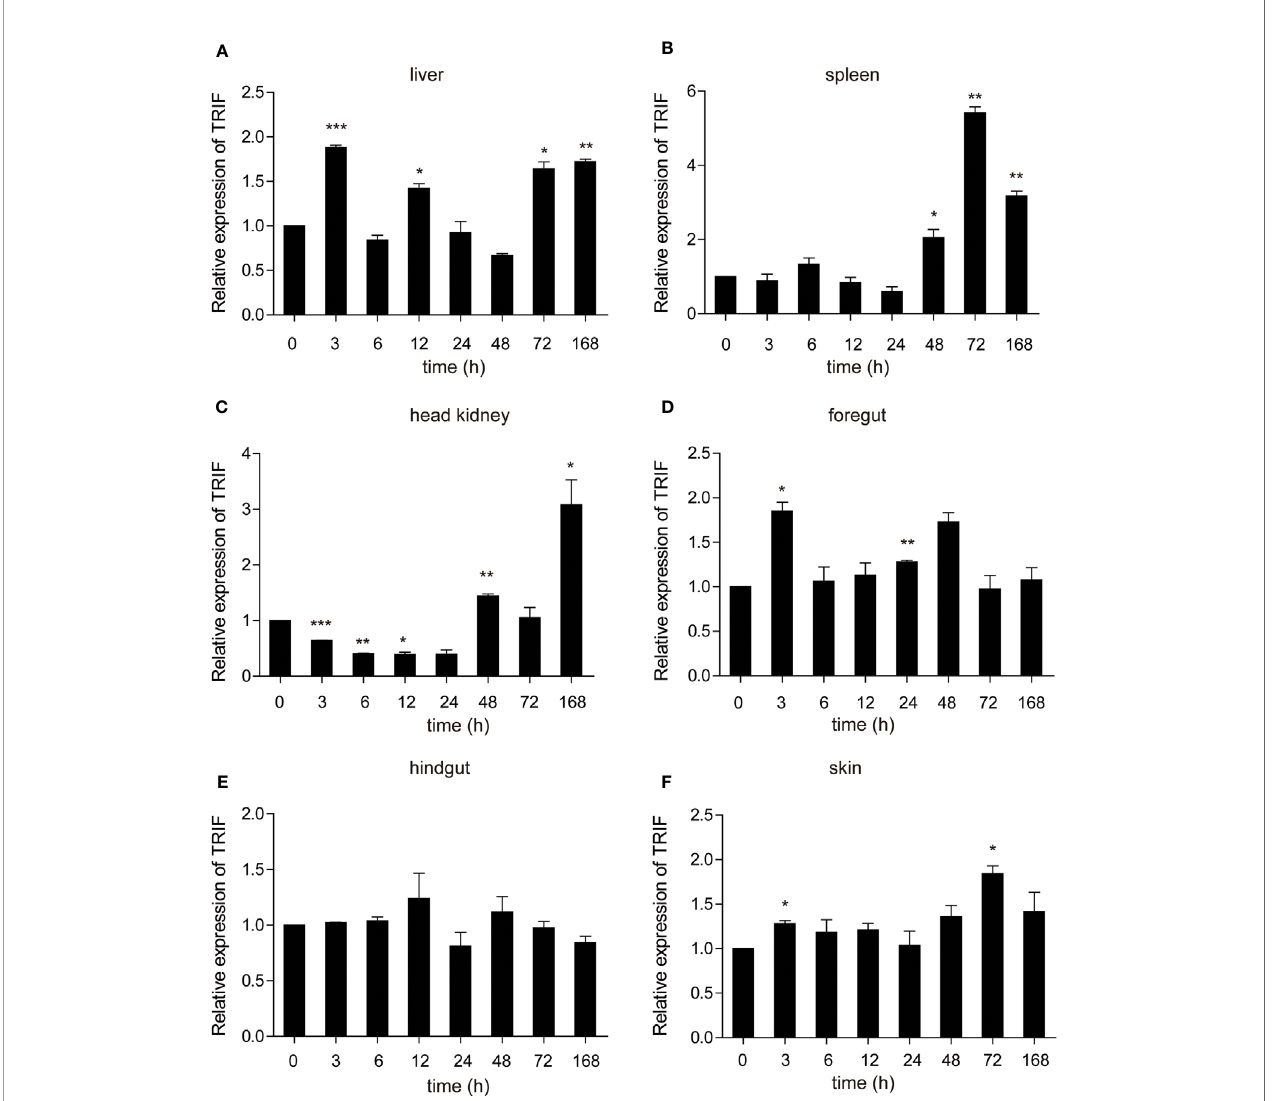
FIGURE 5 | The relative expression of carp TRIF in various tissues of common carp after intraperitoneal injection with poly(I:C). The mRNA expression levels of carp TRIF in the liver (A) , spleen (B) , head kidney (C) , foregut (D) , hindgut (E) , and skin (F) at different time points are shown. Gene expression results were calculated relative to the expression of 40S ribosomal protein s11. Data were presented as the fold changes based on the unstimulated control group (denoted by 0 h). Means ± SD (n = 3), * P < 0.05, ** P < 0.01, *** P <